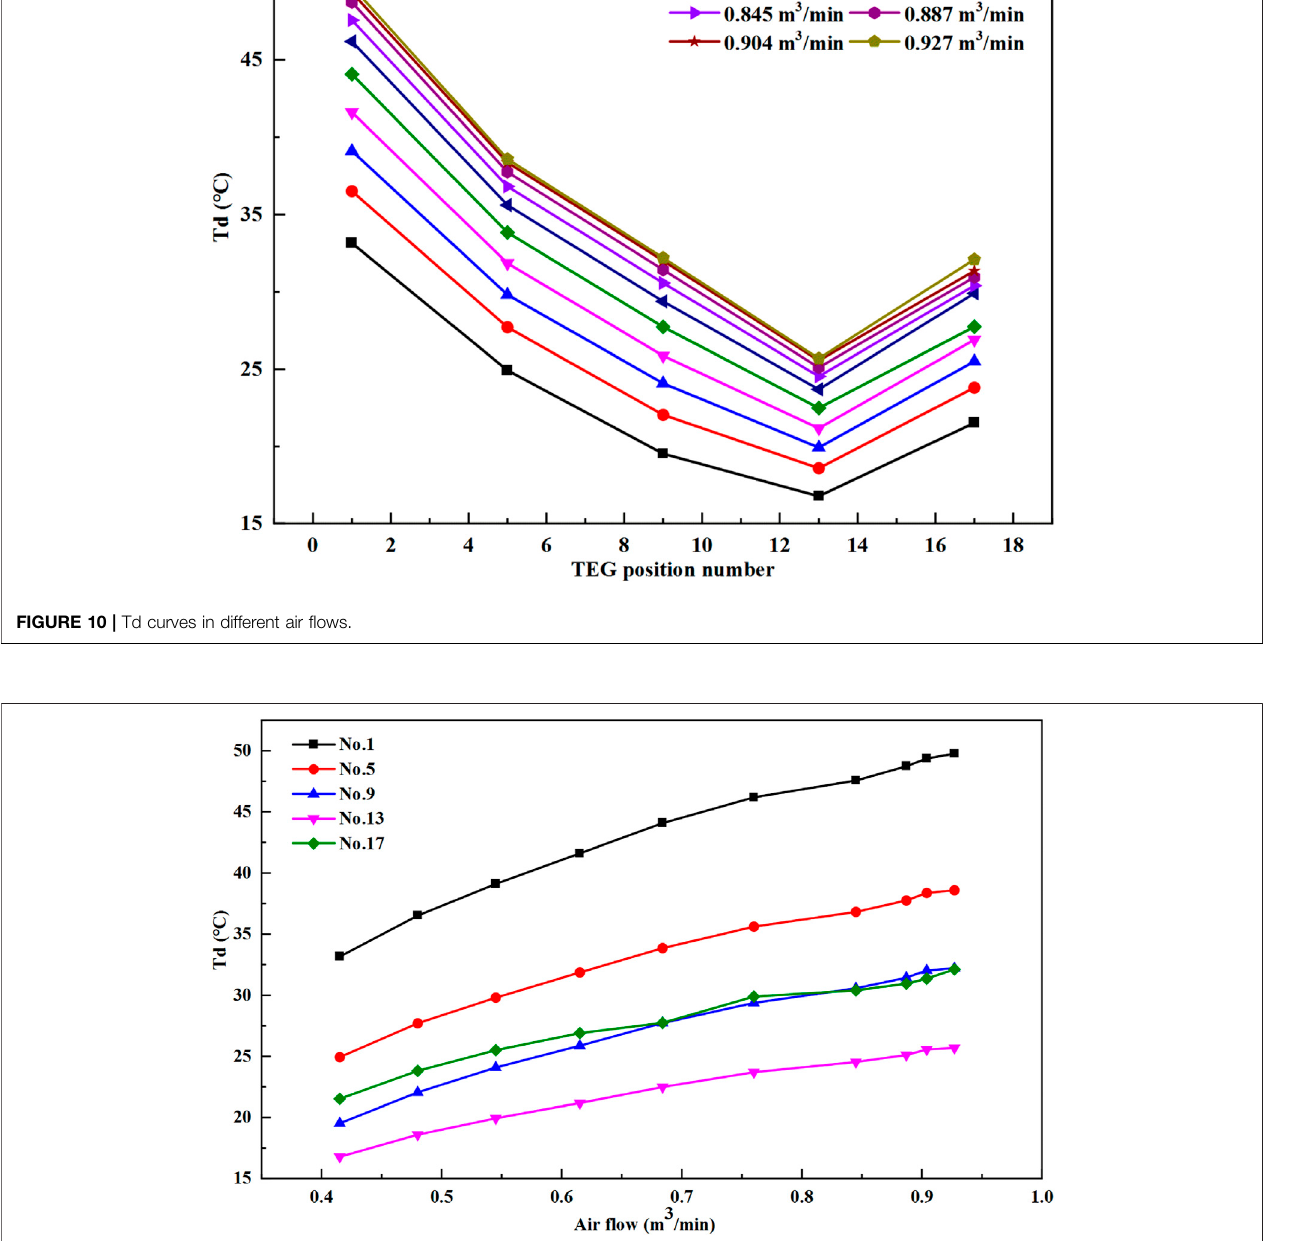
FIGURE 11 | Td curves with air fl ow in different